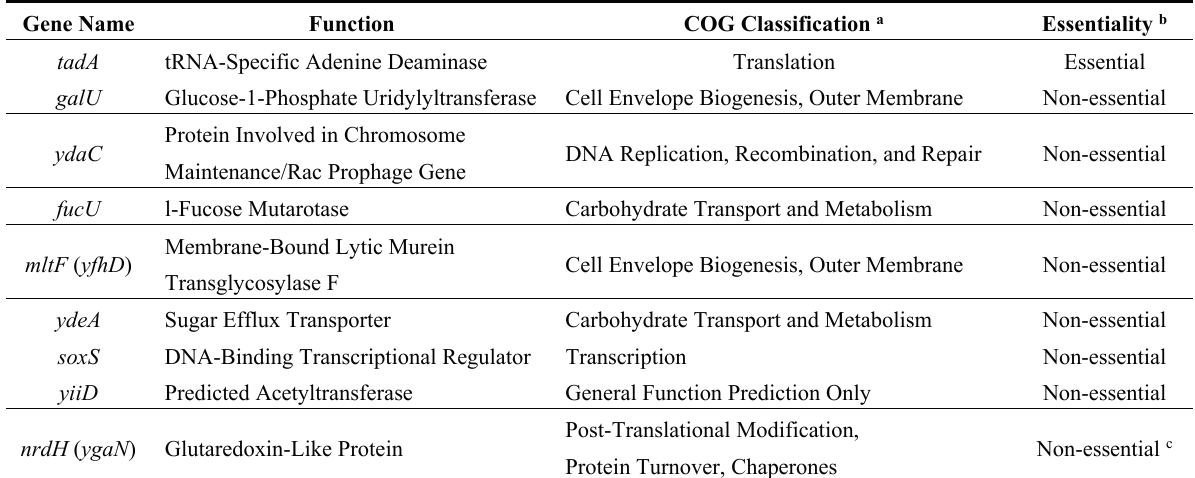
Table 1. List of identified genes in the ASKA pooled-plasmid library